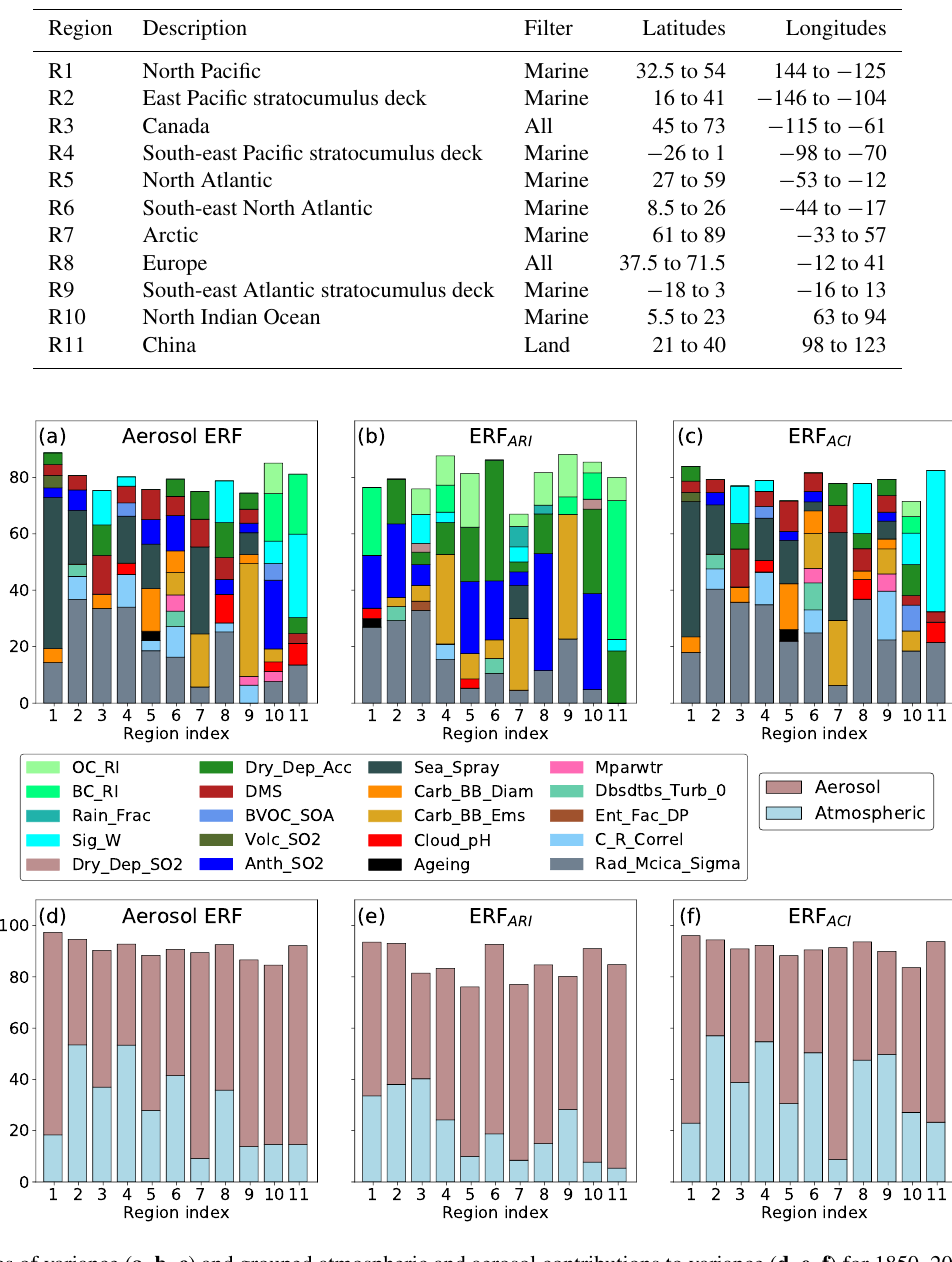
Figure 11. Sources of variance ( a , b , c ) and grouped atmospheric and aerosol contributions to variance ( d , e , f ) for 1850–2008 annual mean ( a , d ) aerosol ERF, ( b , e ) ERF ARI and ( c , f ) ERF ACI for the 11 regions defined in Table 3 and highlighted in Fig.